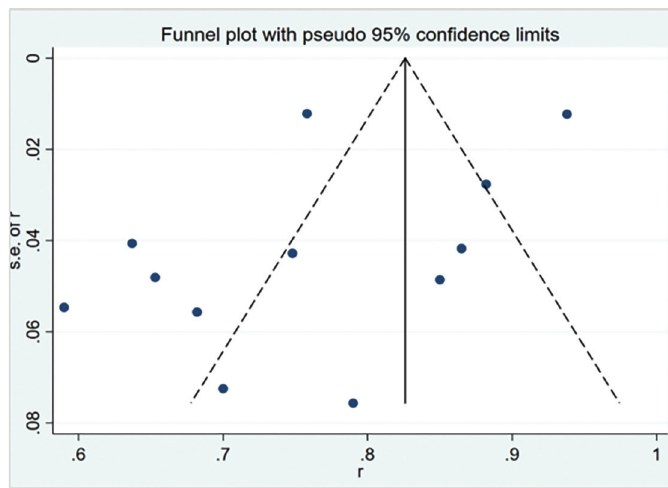
Figure 8. Funnel plot of at least 1 inhaler error made. Begg’s rank correlation test ( P = 0.304) and Egger’s test ( P = 0.223) showed that differences were not statistically significant and no publication bias was